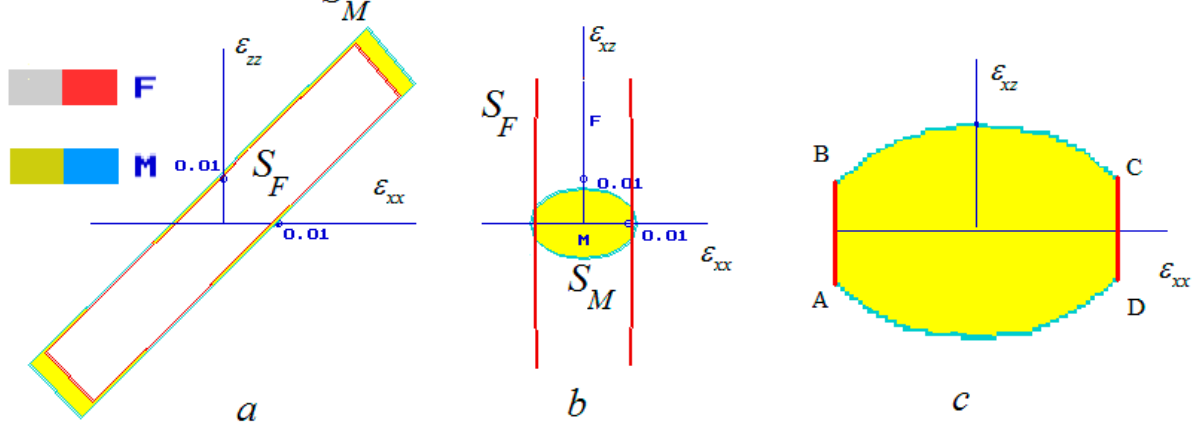
Figure 4. Failure surface for the tension-shift modes: ( a )—in plane O ε , ( b )—enlarged, and ( c )—in plane , ( d )—enlarged .